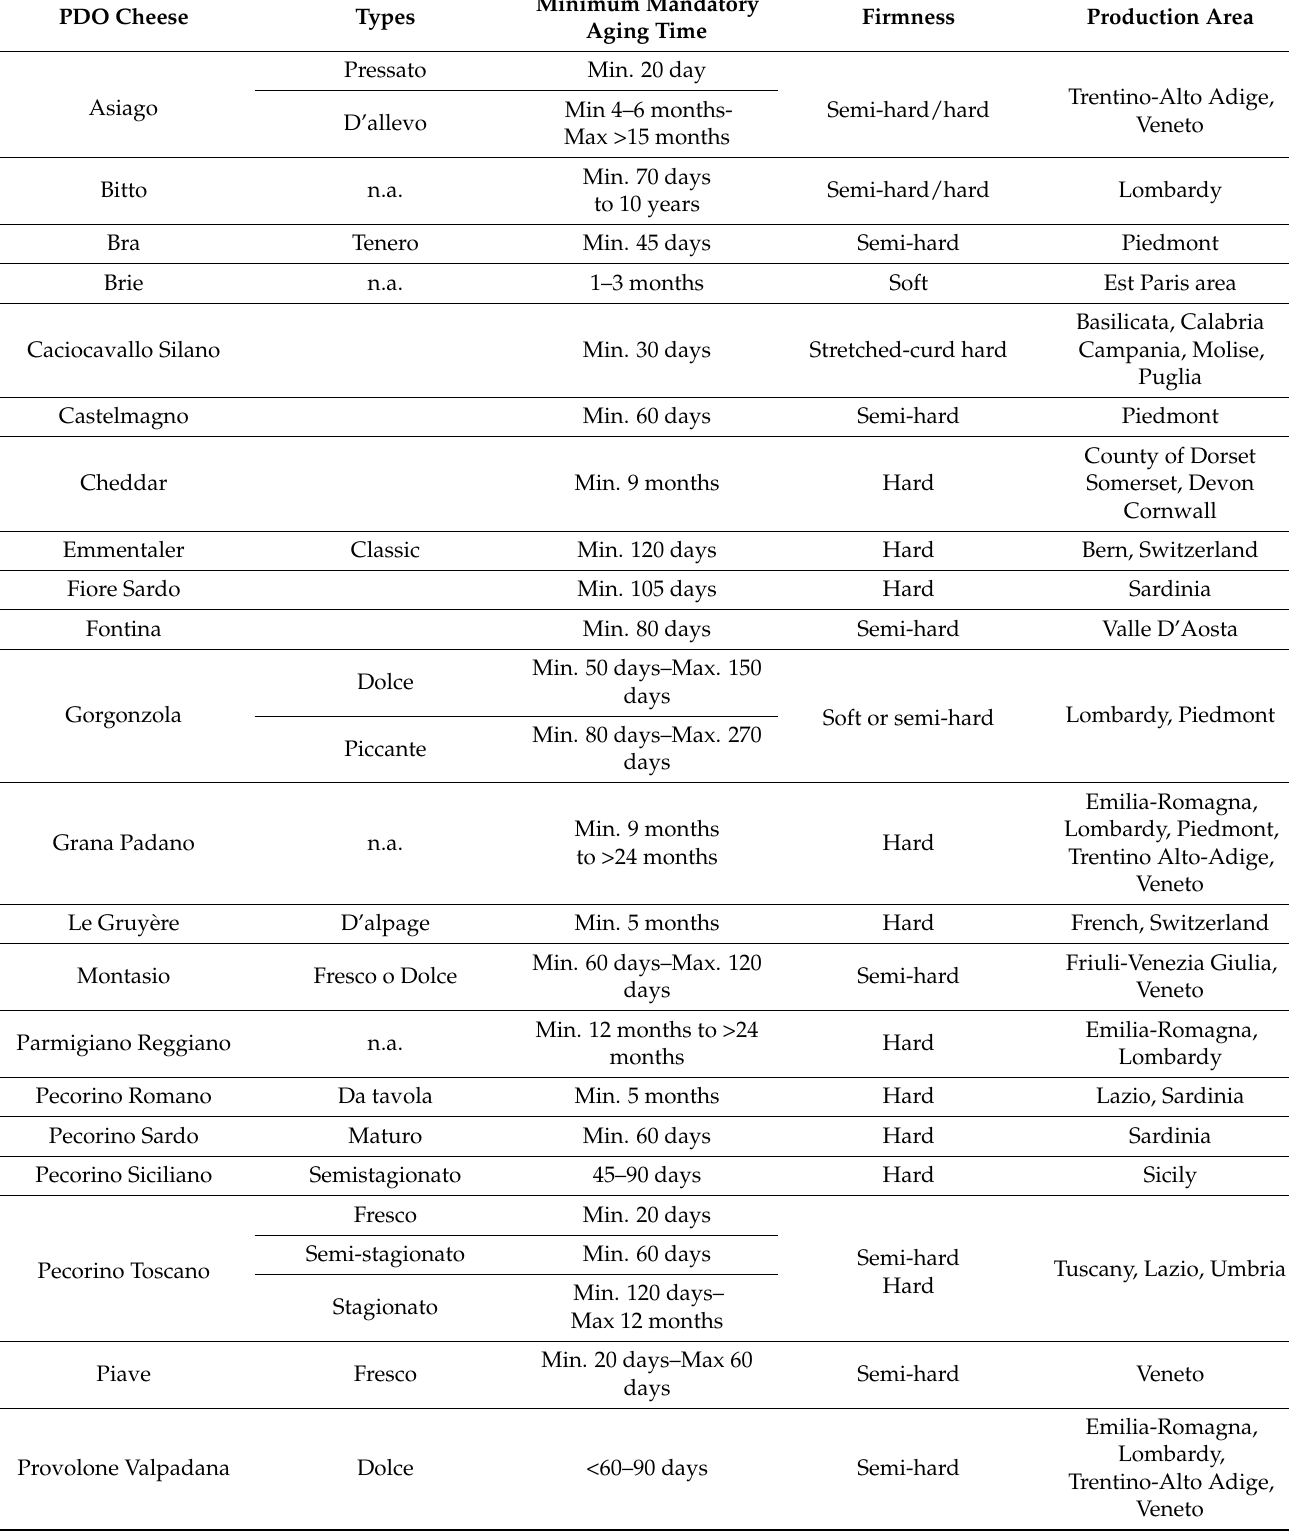
Table 4. Selected PDO cheeses and their types, classified by their ageing time, firmness, and production area. PDO